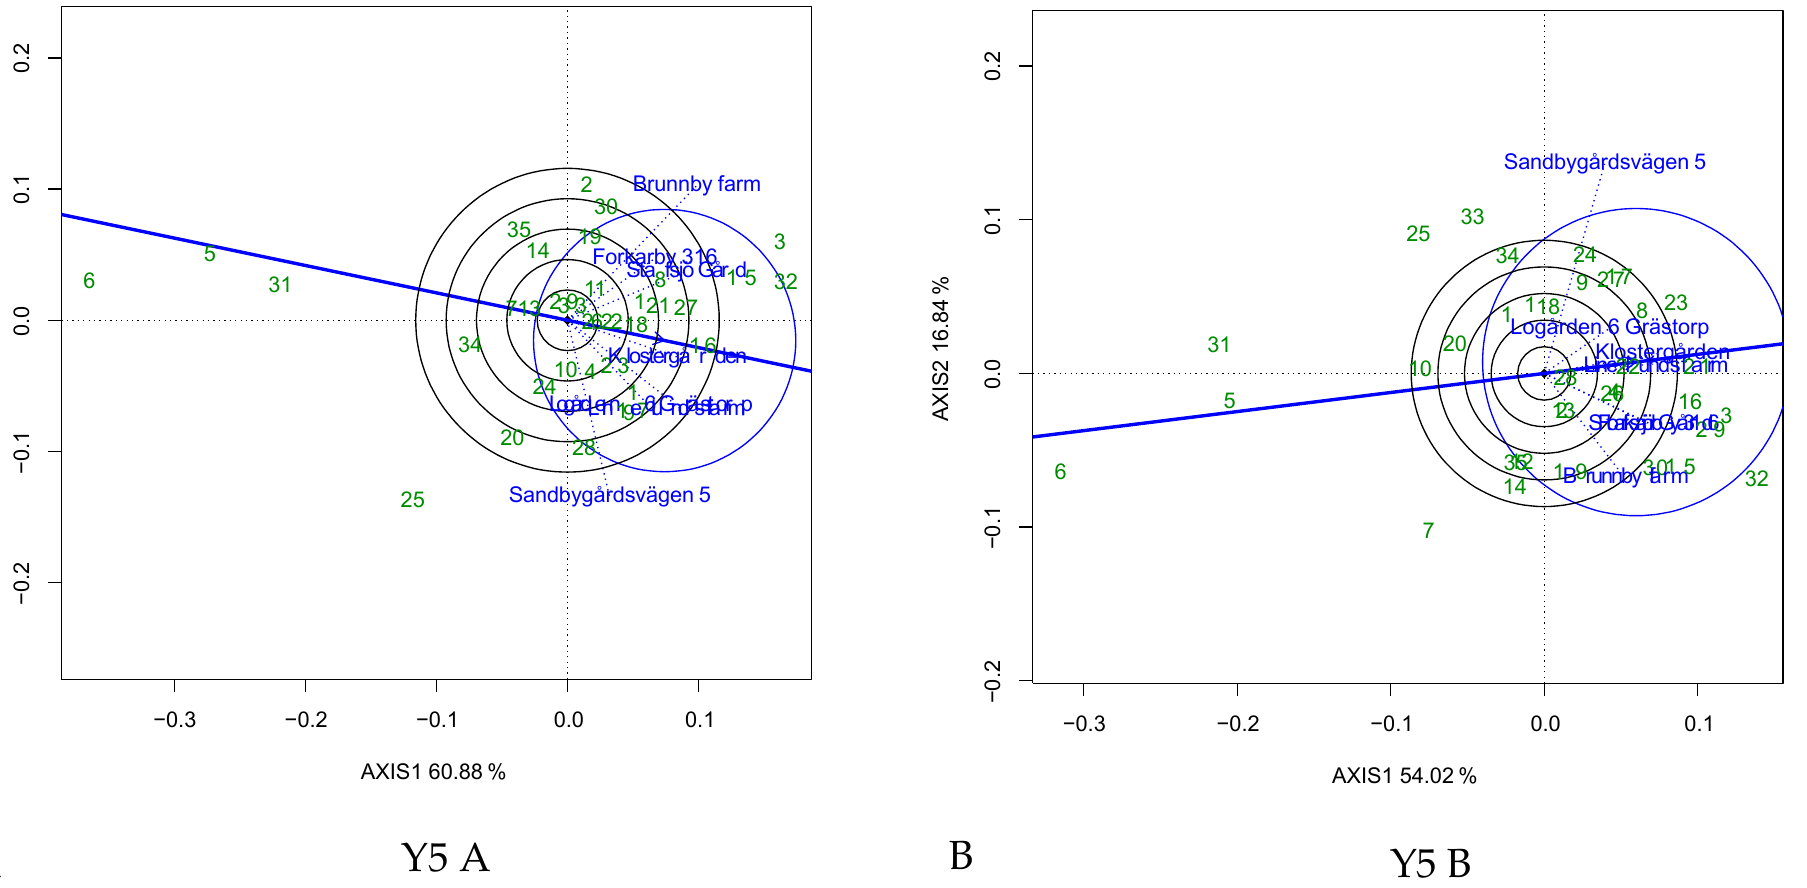
Figure 4. GGE biplot for barley genotypes under untreated ( A ) and treated ( B ) conditions based on environment-focused scaling for the comparison of the tested environments based on average environment axis (AEA), across five years (Y1 to Y5).